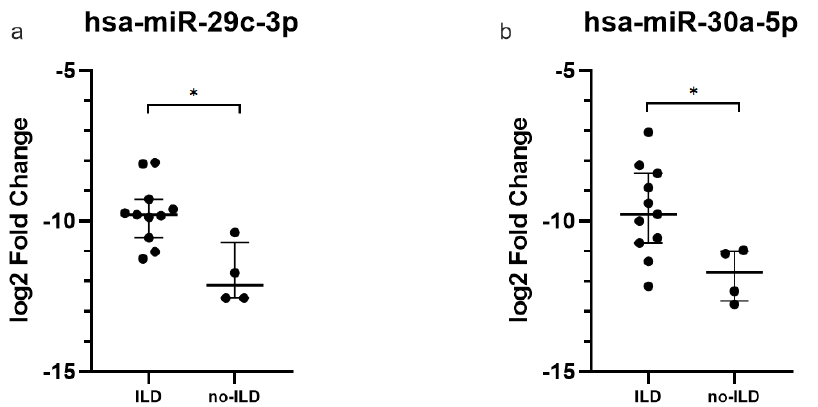
Figure 1. Quantitative expression of ( a ) hsa-miR-29c-3p, and ( b ) hsa-miR-30a-5p in the plasma- derived exosomes of ASSD patients with and without ILD. Log2 transformed values. p -value Bonferroni-corrected * < 0.05.